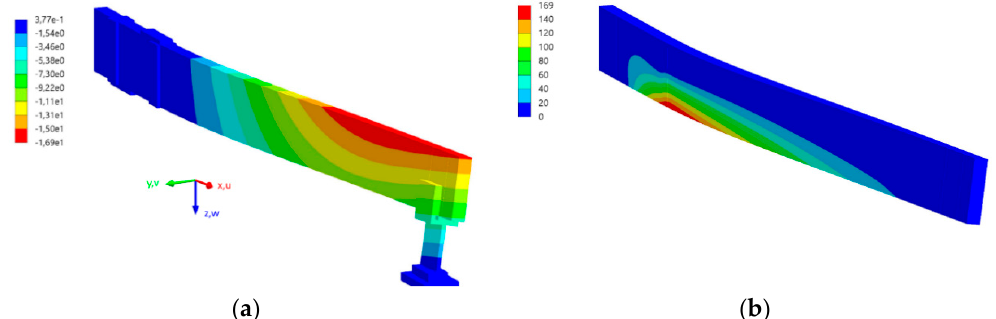
Figure 5. Exemplarily some results from the numerical simulations: ( a ) Lateral displacements v (mm, in y -direction), ( b ) maximum principal stress (MPa).